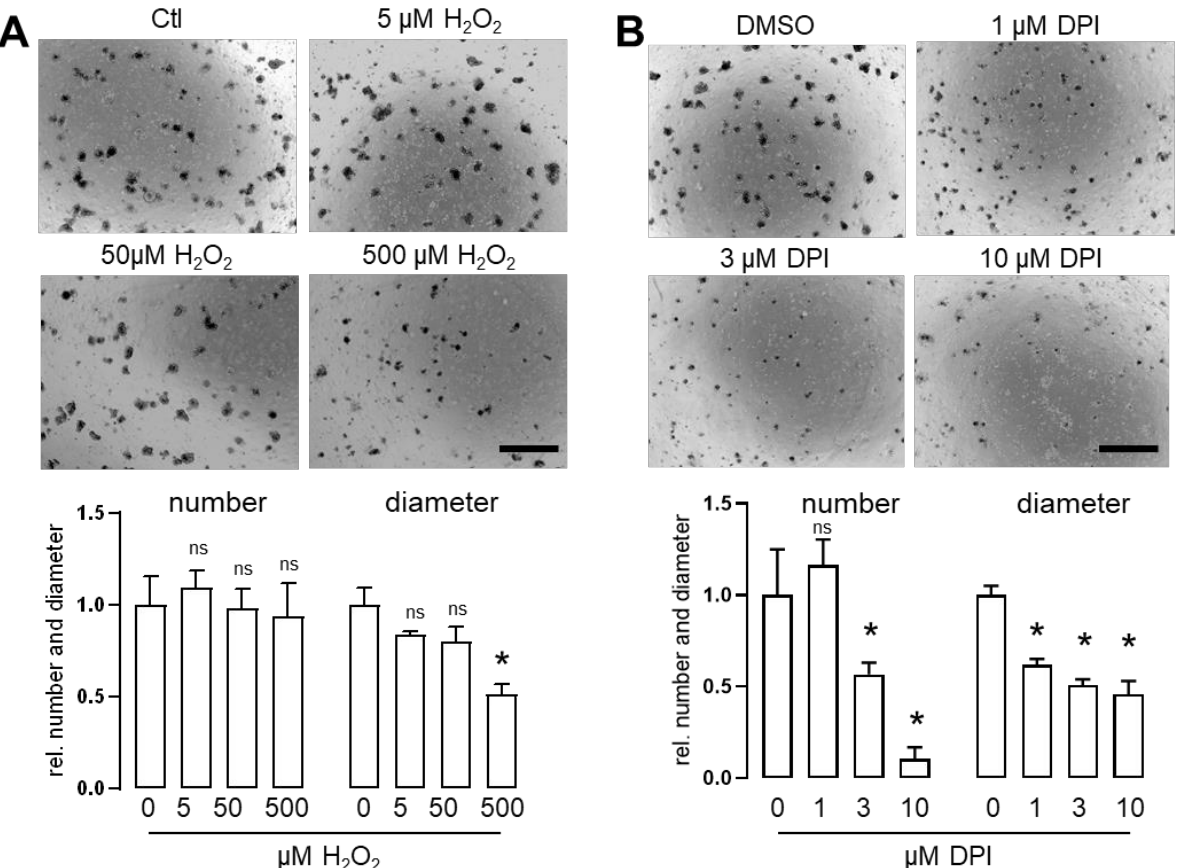
Figure 2. Inhibition of flavoproteins leads to death of organoids. ( A , B ) Small intestinal organoids from C57BL/6 mice were treated with either DMSO, 5 µ M H 2 O 2 ( A ) or 3 µ M DPI (Diphenyleneiodo- nium) ( B ). Organoid number and diameter were measured as a marker for organoid survival and proliferation. Values were calculated relative to untreated control. n= 4–6; mean with SEM; ns: none significant * p < 0.05 ctl vs. treatment indicated (one-way Anova); bars = 500 µ